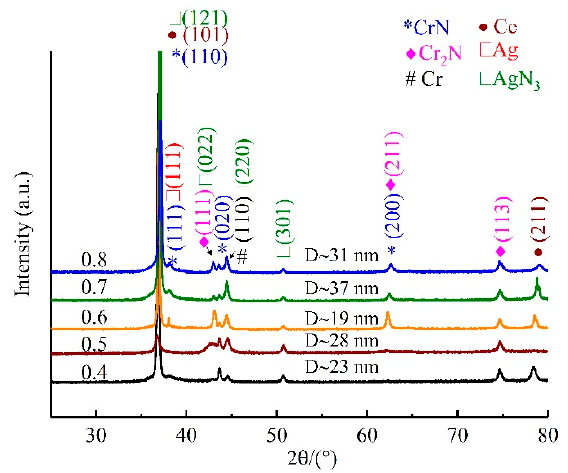
Figure 2. XRD patterns of the CrAgCeN coatings deposited at different pressures (in Pa, listed along the left axis).